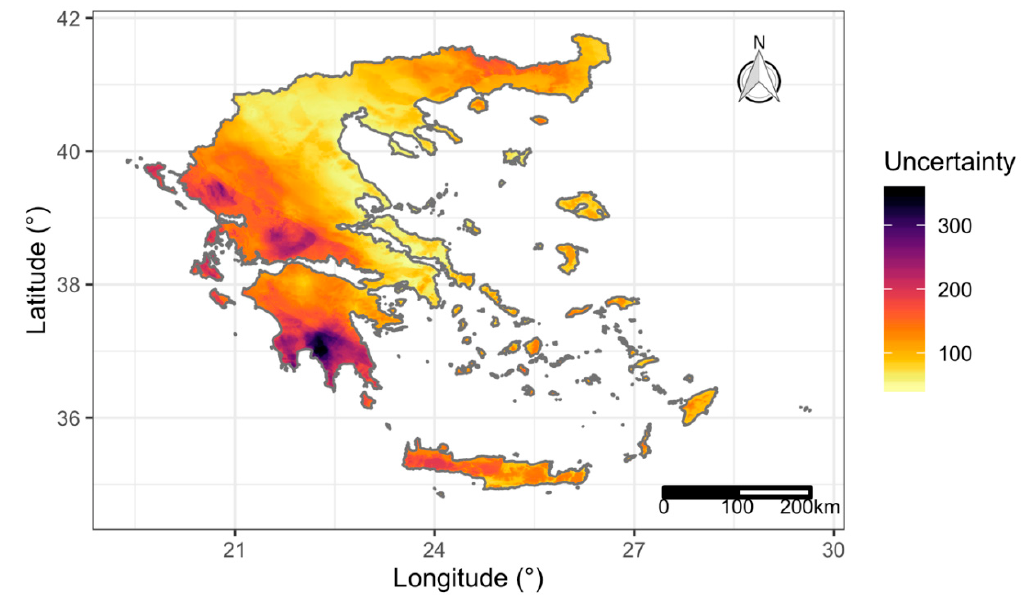
Figure 6. Annual rainfall erosivity. Values are in MJ·mm/ha/h/y. Available online in supplementary materials.